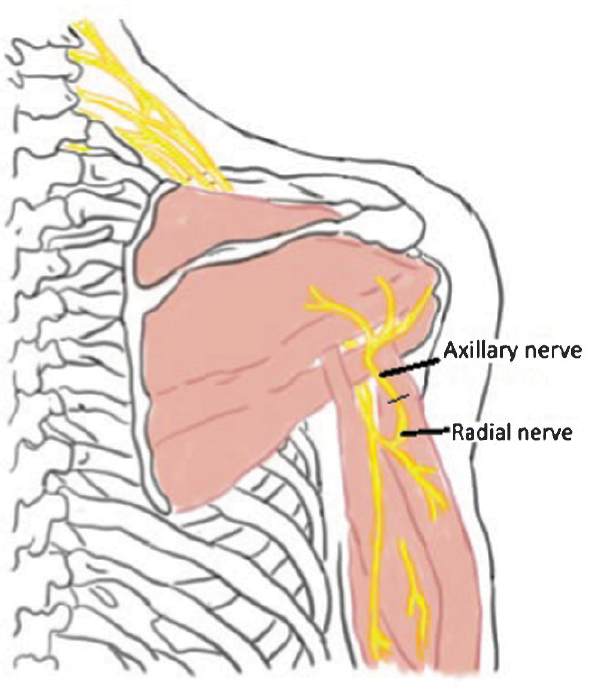
Figure 1 - Radial nerve to axillary